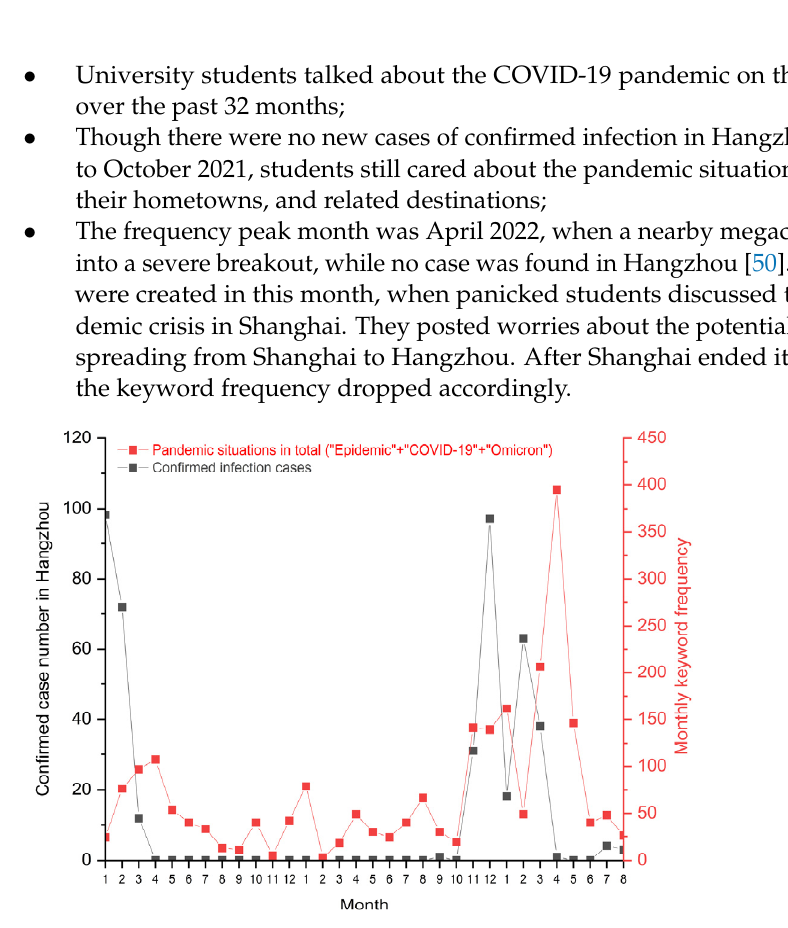
Figure 3. Monthly keyword frequency about the pandemic as compared with the number of con- firmed infection cases in Hangzhou.